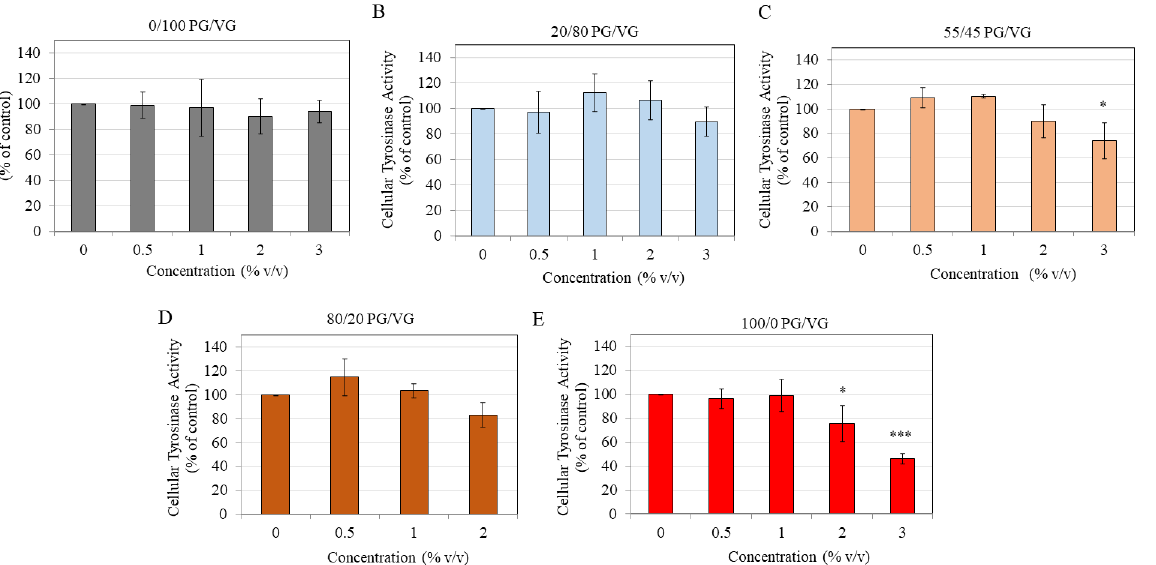
Figure 4. Bright-field images of human melanocytes at 40× magnification after 48 h exposure to a 2% v/v e-liquid solution containing PG/VG at a ratio of 0/100, 20/80, 55/45, 80/20, and 100/0. Red arrows denote the melanin granules within cells.